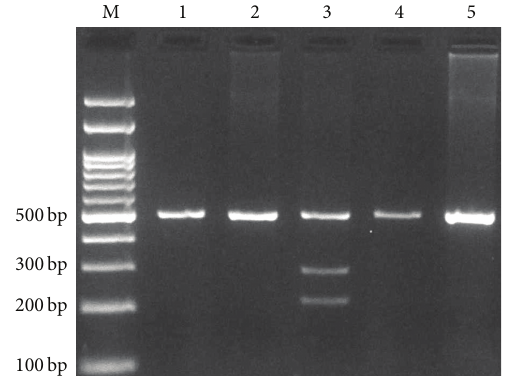
Figure 2: Electrophoresis pattern of PCR-RFLP for detection of IFNGR1 rs11914 polymorphism. G allele digested by TaqI restriction enzyme and produces 286 and 210 bp while the T allele undigested